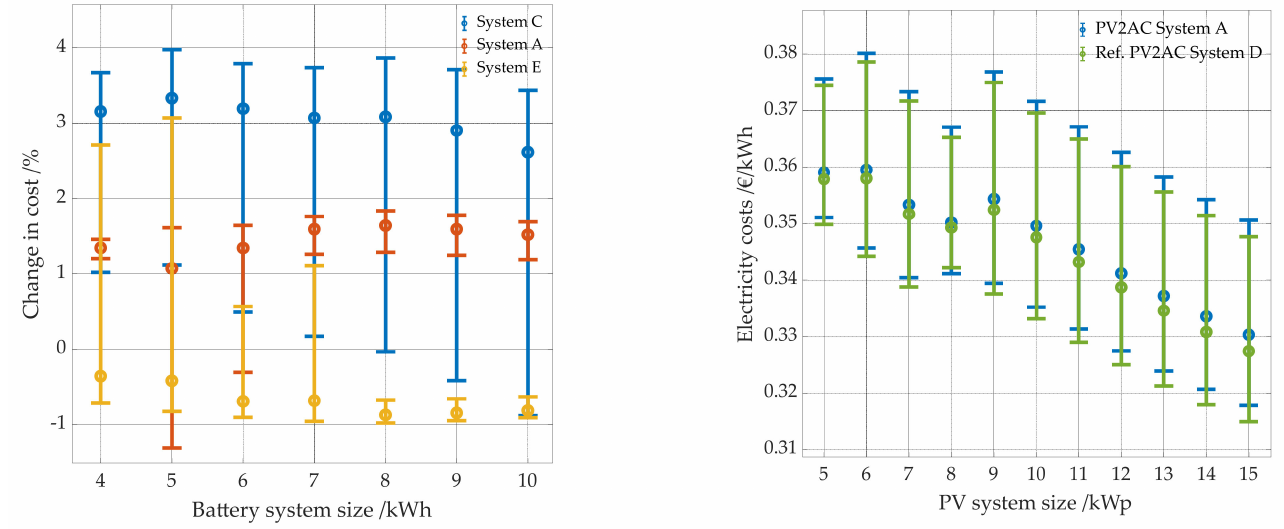
Figure 16. Change in electricity costs per kWh of the reference case to the 3 other simulations with the battery inverter efficiency curve of system C, A and E as a function of the battery system size ( left panel). Electricity costs per kWh as a function of the PV system size ( right panel). Simulations were performed with the efficiency curves of systems A and D with an average pathway efficiency of 95.51 and 96.29% for the path